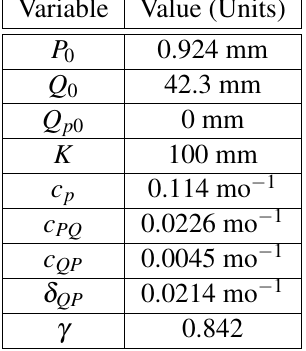
Table 4 Values of the biological parameters in the model of LGG evolution.